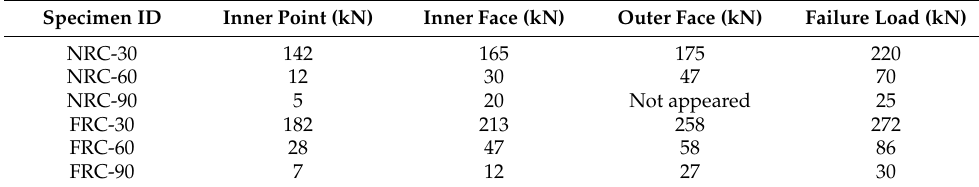
Table 5. First cracking load at each